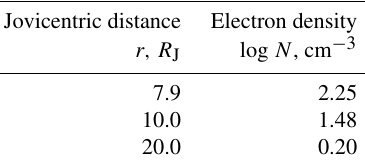
Table 1. Equatorial parameter values for Jupiter’s thermal charged particle populations (from Table 7 of Divine and Garrett,